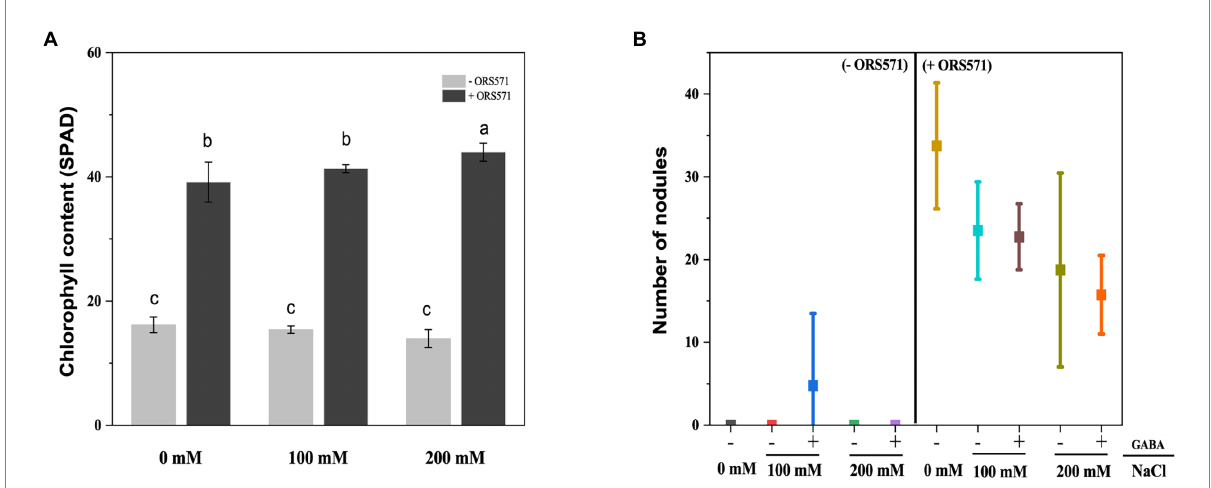
FIGURE 3 Chlorophyll content in leaf samples and nodule number inoculated with ORS571 or not under different salt concentrations. (A) The chlorophyll content of the inoculated group under salt stress was significantly higher than that of the uninoculated group. (B) The number of nodules formed by ORS571 was detected and decreased with increasing salt concentration. Different lower-case letters in each column shape indicate a significant difference at p < 0.05 by statistical analysis. Error bars indicate standard deviations from four parallel replicates.